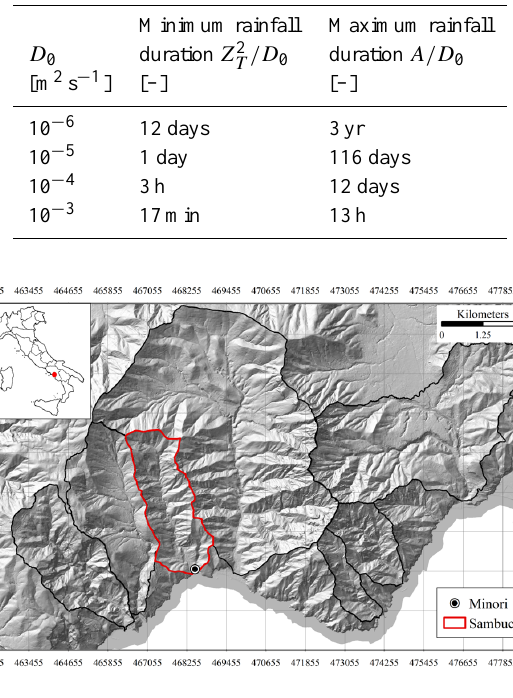
Fig. 3. Geographical context of the study area (WGS, 1984, UTM Zone 33 ◦